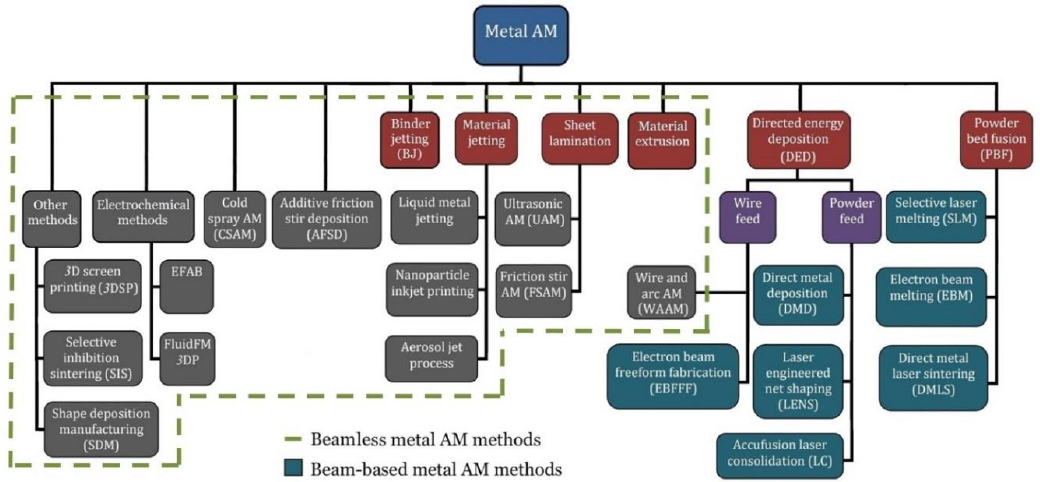
Figure 1. Classification of the main current metal AM processes, including beam-based and beamless techniques.